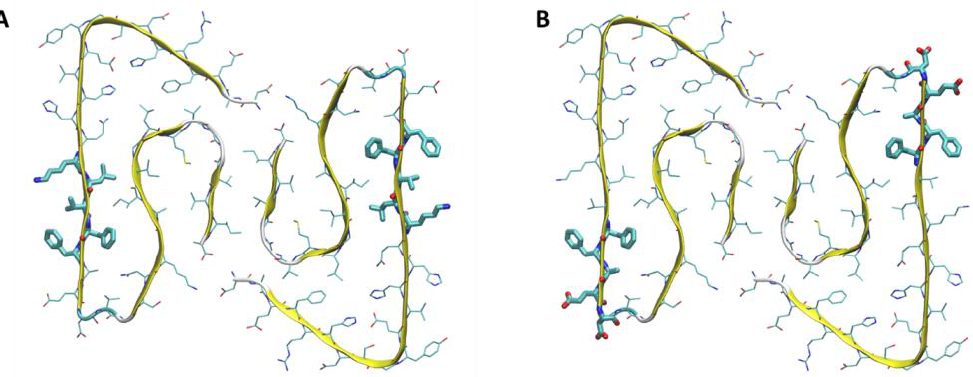
Figure 4. Amino acids most involved in the interactions ( A ) with the neutrally charged NPs and ( B ) with the positively charged NPs.